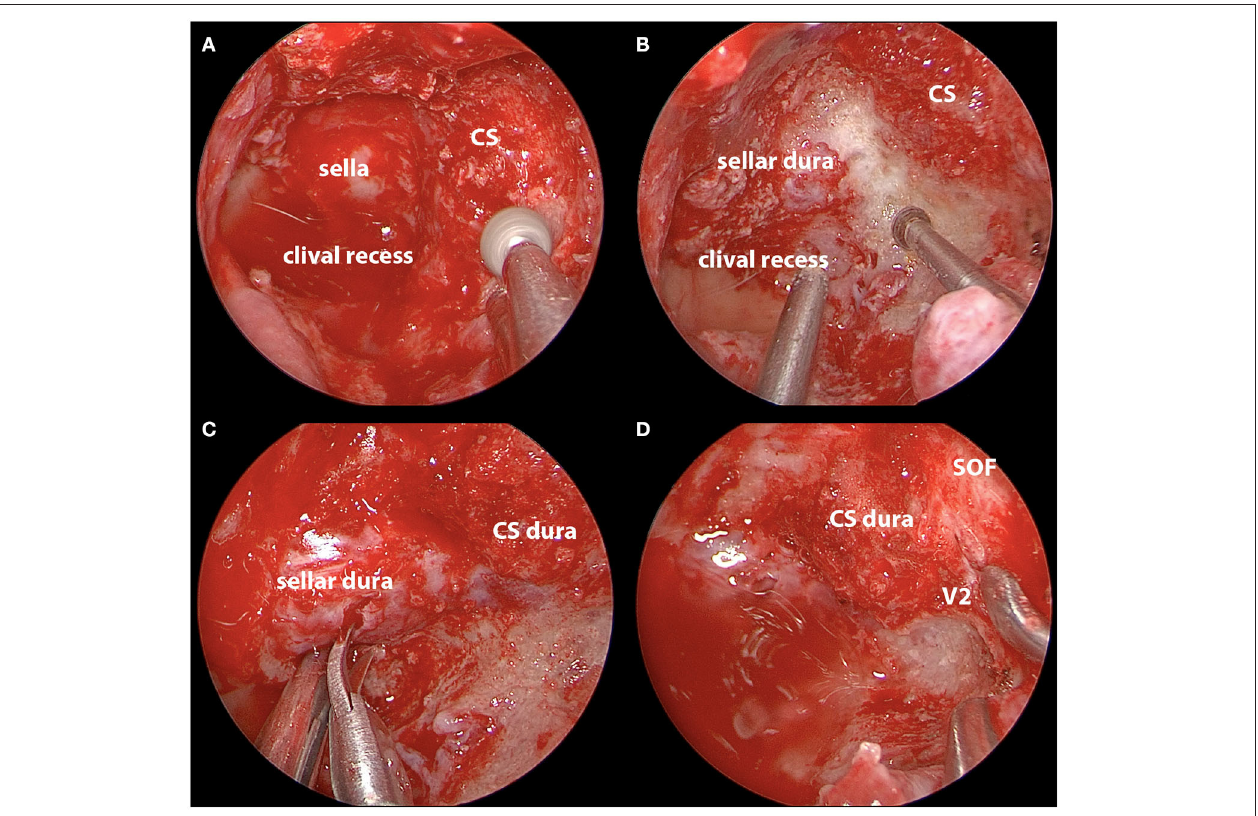
FIGURE 6 | Intraoperative images of endoscopic endonasal decompression for a left side CS meningioma. (A) Drilling down the hyperostotic bone overlying the CS; (B) exposure of the sellar dura; (C) opening the sellar interdural space after complete decompression; (D) decompression of bone overlying the sella, medial SOF, and CS. CS, cavernous sinus; SOF, superior orbital fissure; V2, maxillary nerve.